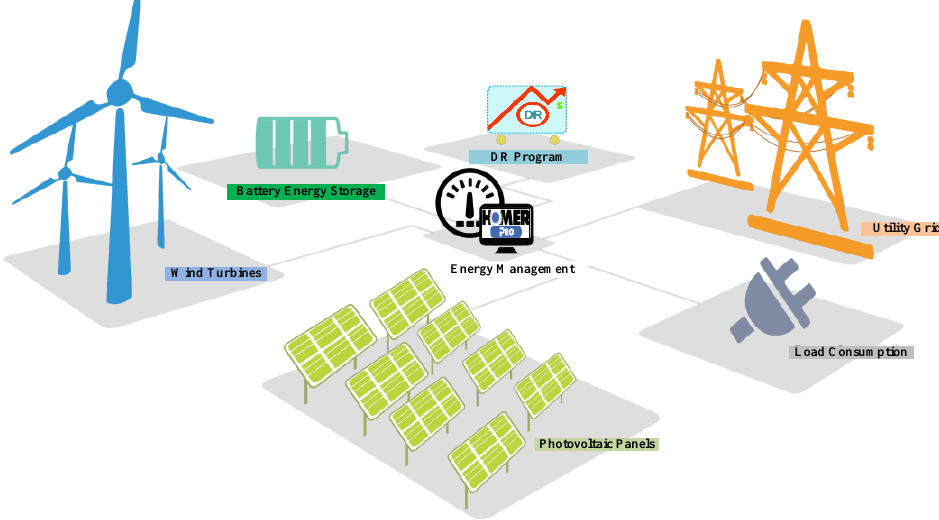
Figure 1. Structure of the MG with energy management module.